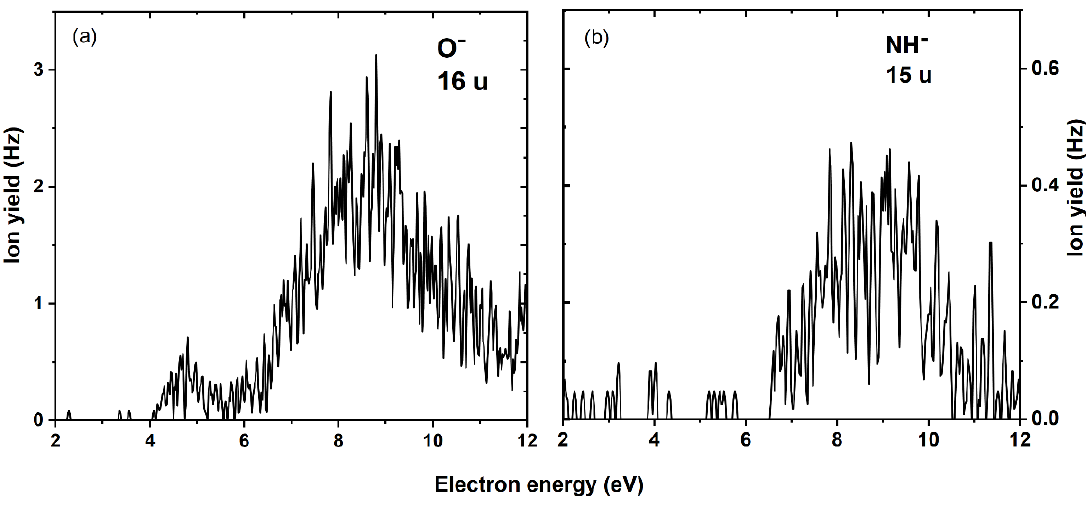
Figure 4. Anion efficiency curve for fragment anions ( a ) O − and ( b ) NH − formed upon DEA to DMSU.